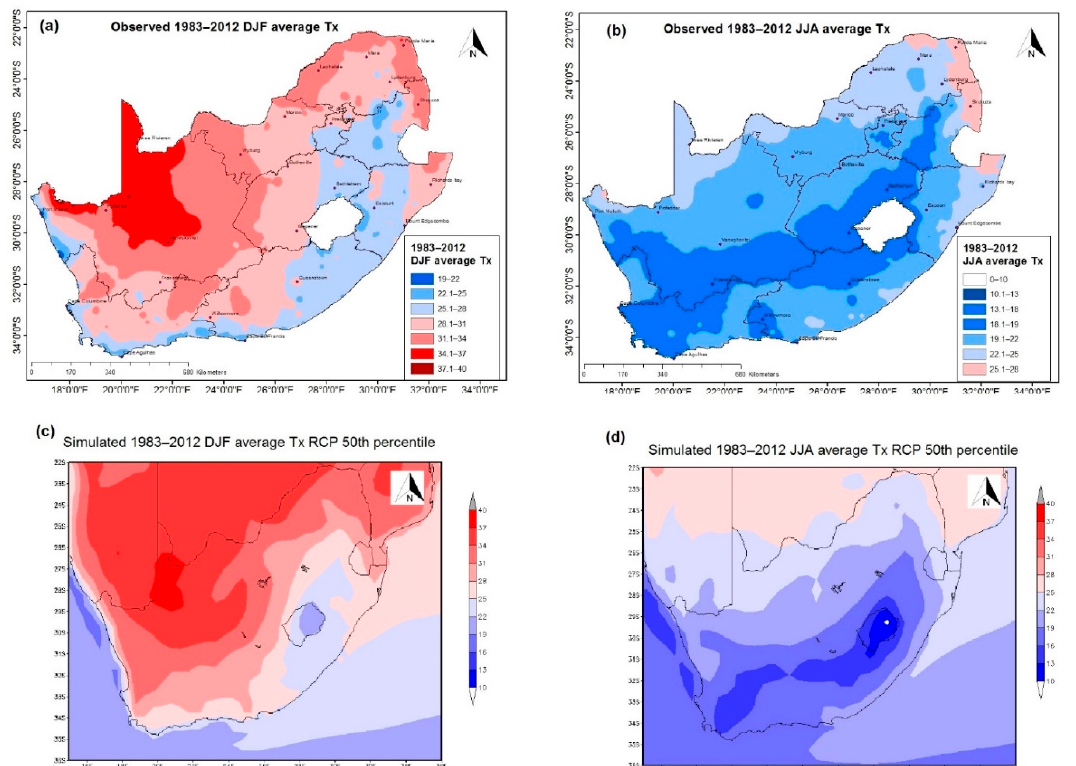
Figure 2. Observed 1983–2012 average Tx ( ◦ C) for ( a ) December–February (DJF) and ( b ) June–August (JJA) and simulations of 1983–2012 RCP 4.5 scenario 50% percentile average Tx ( ◦ C) for ( c ) DJF and ( d ) JJA.